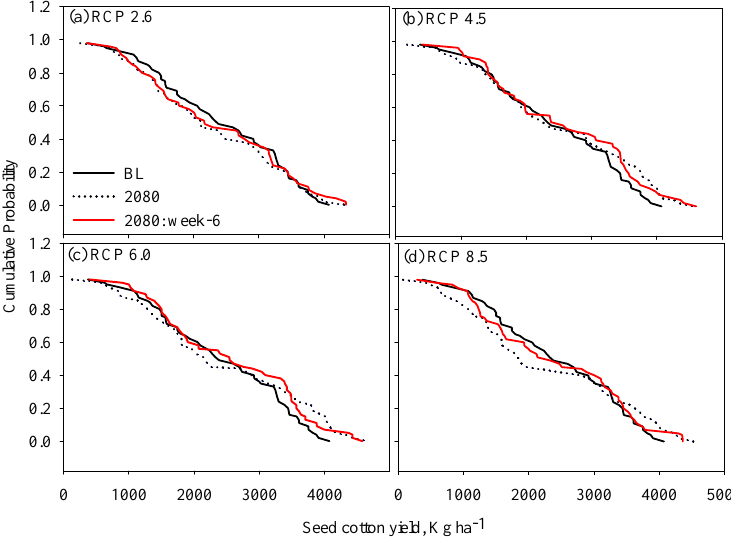
Figure 14. Comparison between the simulated rainfed seed cotton yield under baseline (BL) climate and climate change (CC; changes in CO 2 , temperature, and rainfall) in 2080 under RCP 2.6 ( a ), 4.5 ( b ), 6.0 ( c ), and 8.5 ( d ) for normal day of planting (2 May) and earlier than normal-day plantings of six weeks (week-6).